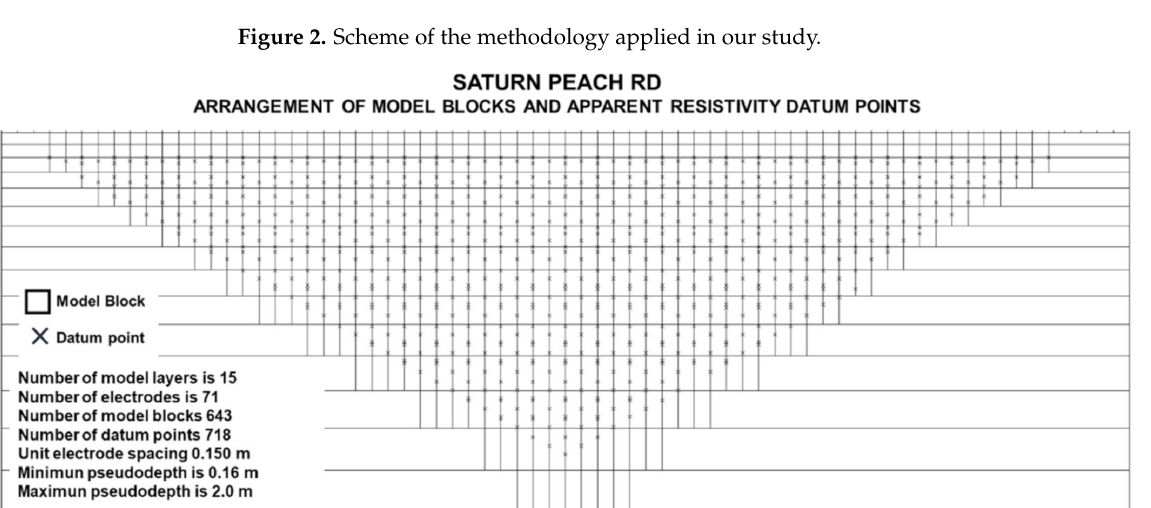
Figure 2. Scheme of the methodology applied in our study.